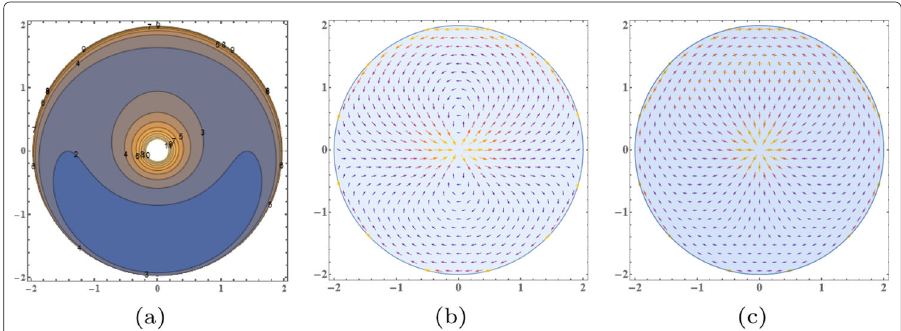
Fig. 7 The correlation fields D ( 0,0 ) ( r ) in q ( a ), ( 1,0 ) · D ( 1,1 ) ( r ) ( b ), and D ( 0,2 ) ( r ) ( c ) in homogeneous 2 π distributions of loops with polarization in horizontal direction as described in the text. Contours are labeled by function value in ( a ). Length and color of the arrows indicate the magnitude of the vectors, qualitatively, in ( b ) and ( c )